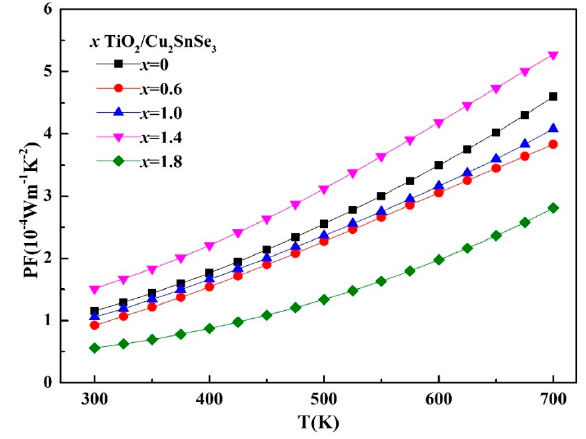
Figure 8. Temperature dependence of power factor (PF) for the TiO 2 /Cu 2 SnSe 3 composites.